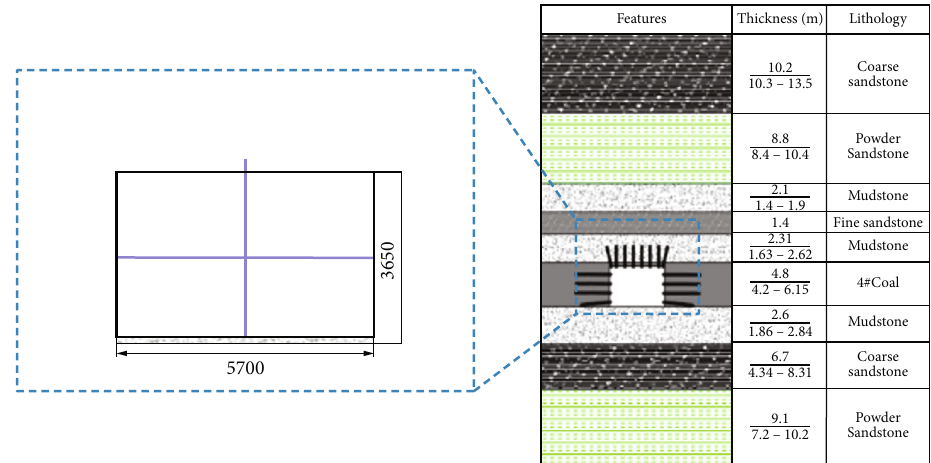
Figure 2: The lithological characteristics of the section and surrounding rock of 4102 headgate.